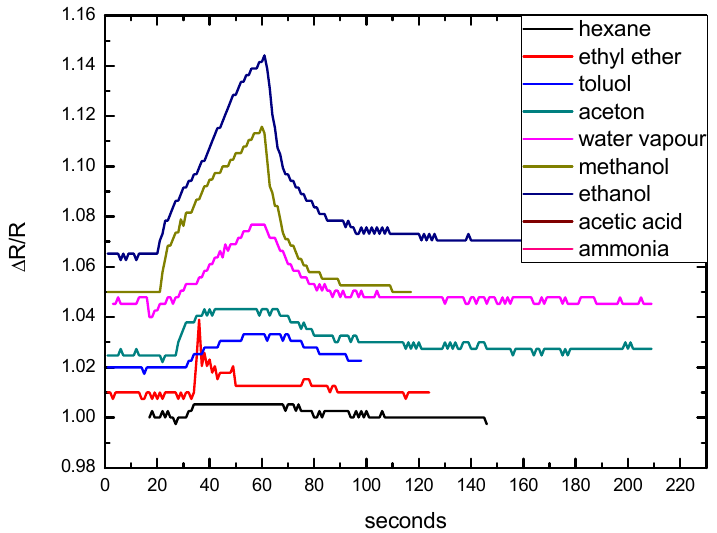
Figure 8. Test of sensitivity of the network of NH 2 − C 2 − MWCNT based sensor to different chemicals, obtained by exposing the sensor to a saturated cotton swab and showing similar rise and recovery times. The sensor base resistance was 820 Ohm.